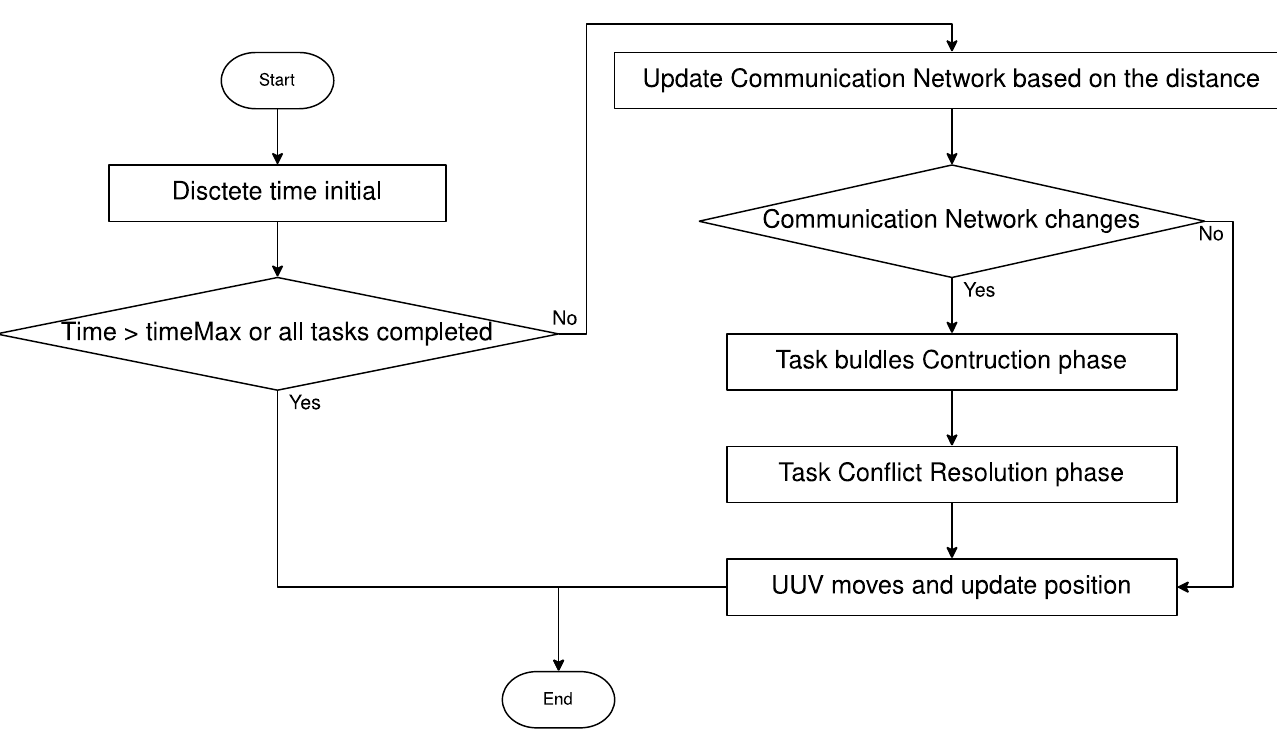
Figure 3. Flowchart of algorithm.